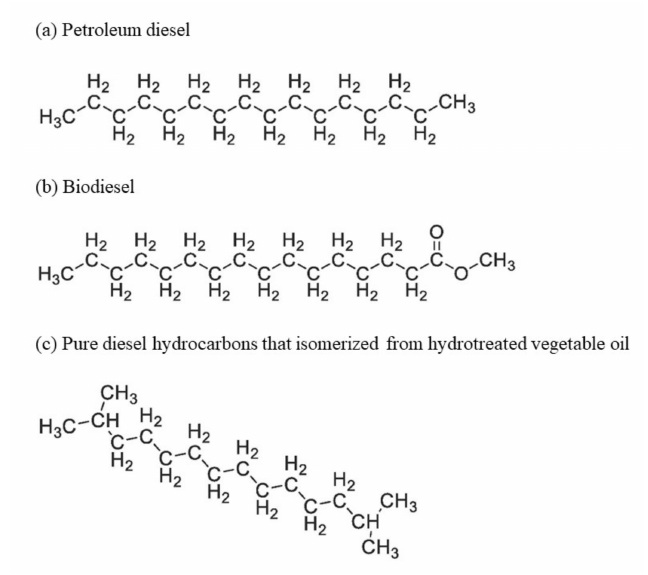
Figure 1. Structure of ( a ) petroleum diesel, ( b ) biodiesel, and ( c ) renewable diesel. Adapted with permission from ref. [11]. 2022 Elsevier.